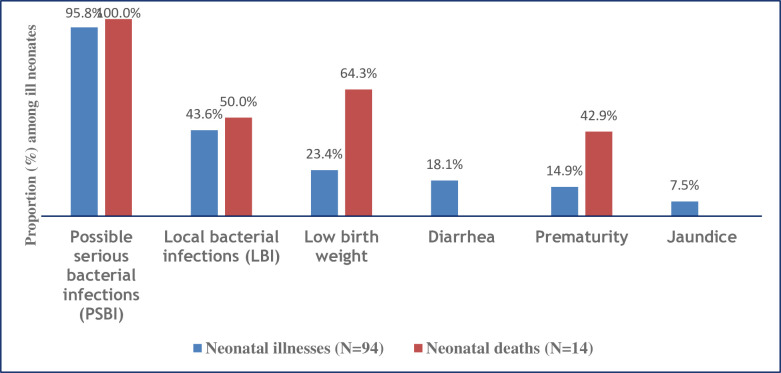
Distribution of neonatal illnesses and proportion of deaths based on symptoms or conditions among the ill neonates in Northwest Ethiopia, March 2019.(Due to multiple neonatal illnesses, the percentage adds up more than 100%).